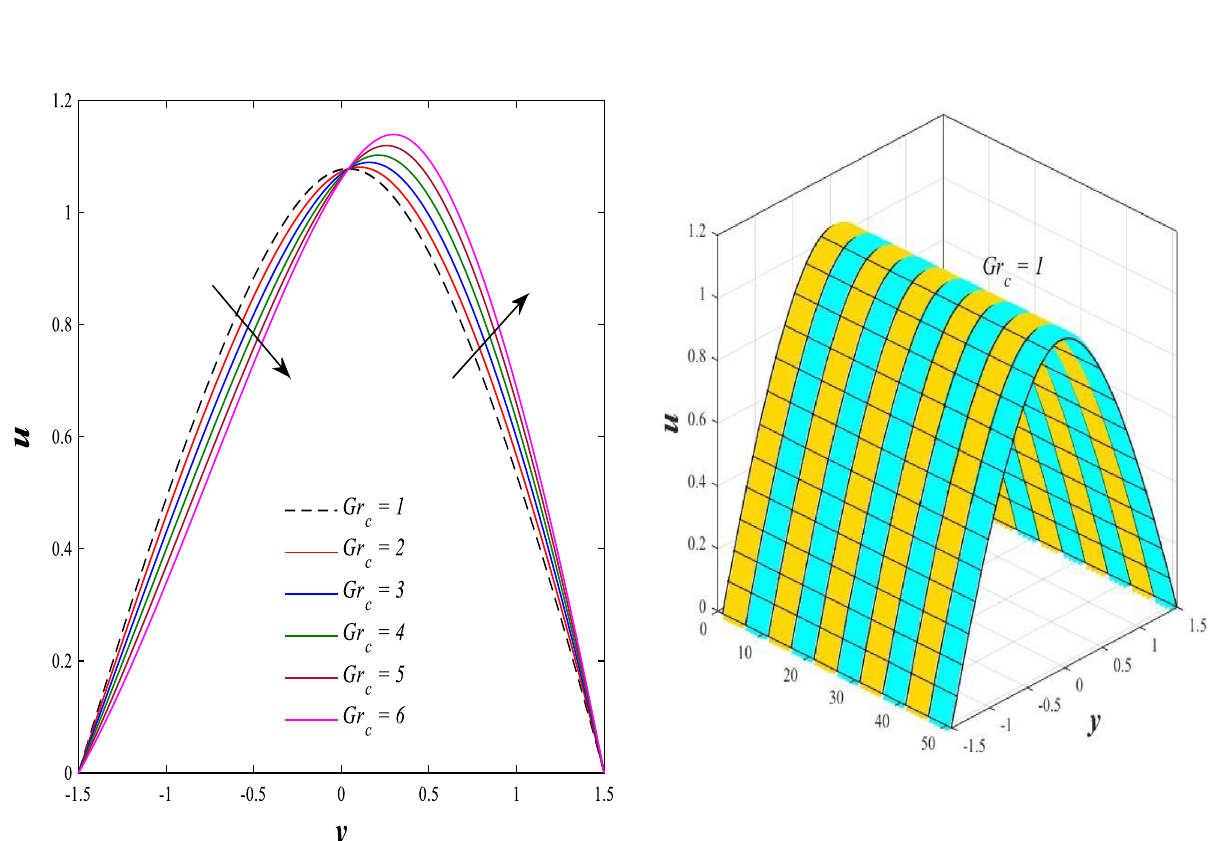
Figure 6. Effect of solutal Grashof number Gr c on the axial velocity distribution 2D and